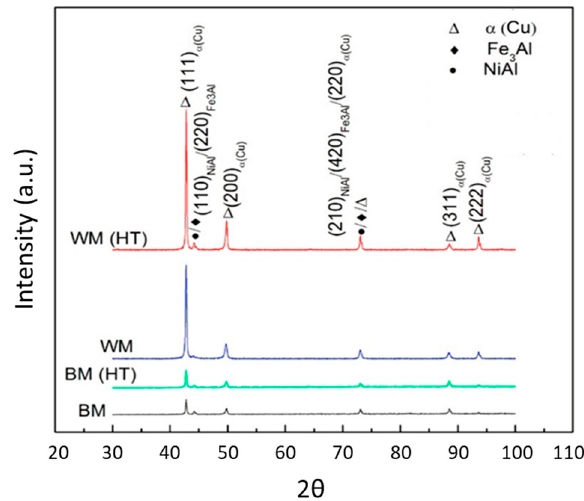
Figure 25. Phase constituents of as-cast base material (BM), as-deposited WAAM part (WM), heat- treated base material (BM HT), and heat-treated (WM HT) (adapted from [8]).